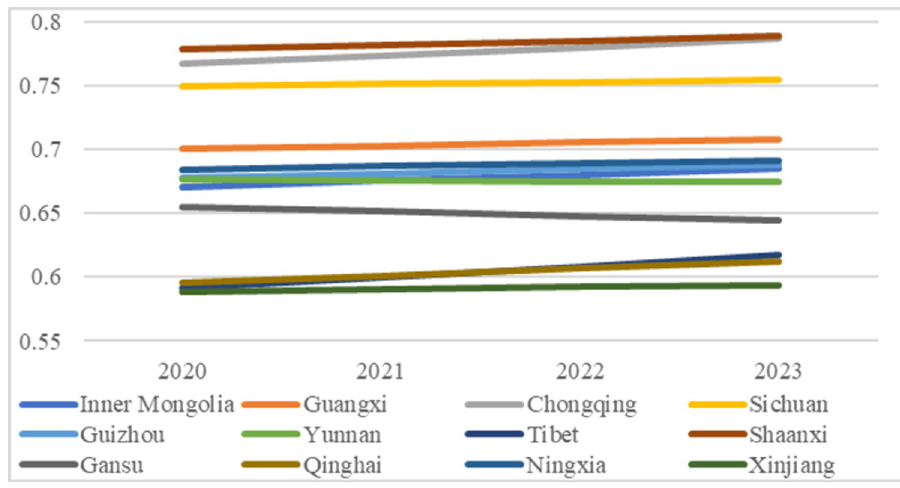
Fig 8. Temporal predictions of